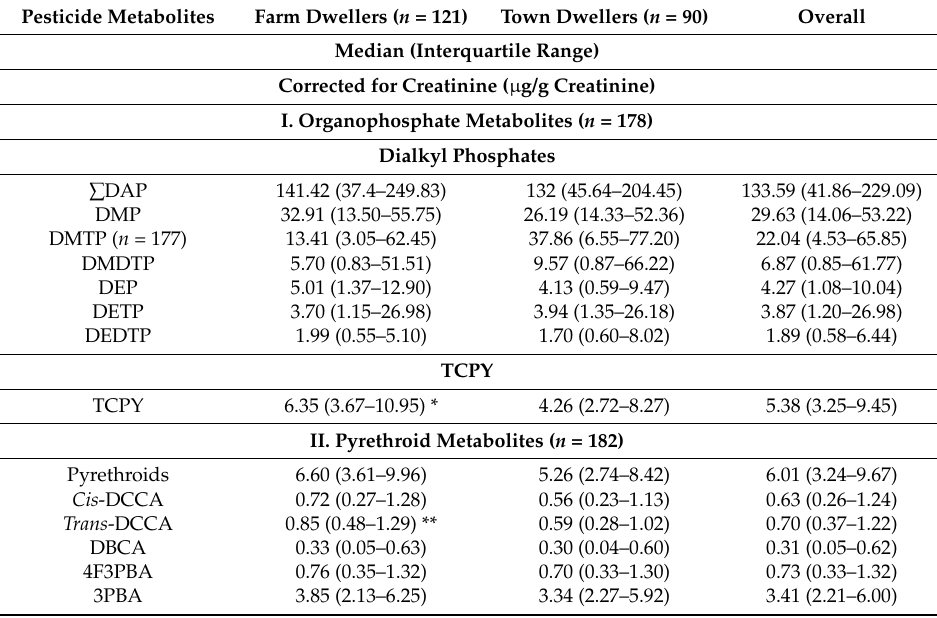
Table 2. Urinary pesticide metabolites levels among rural